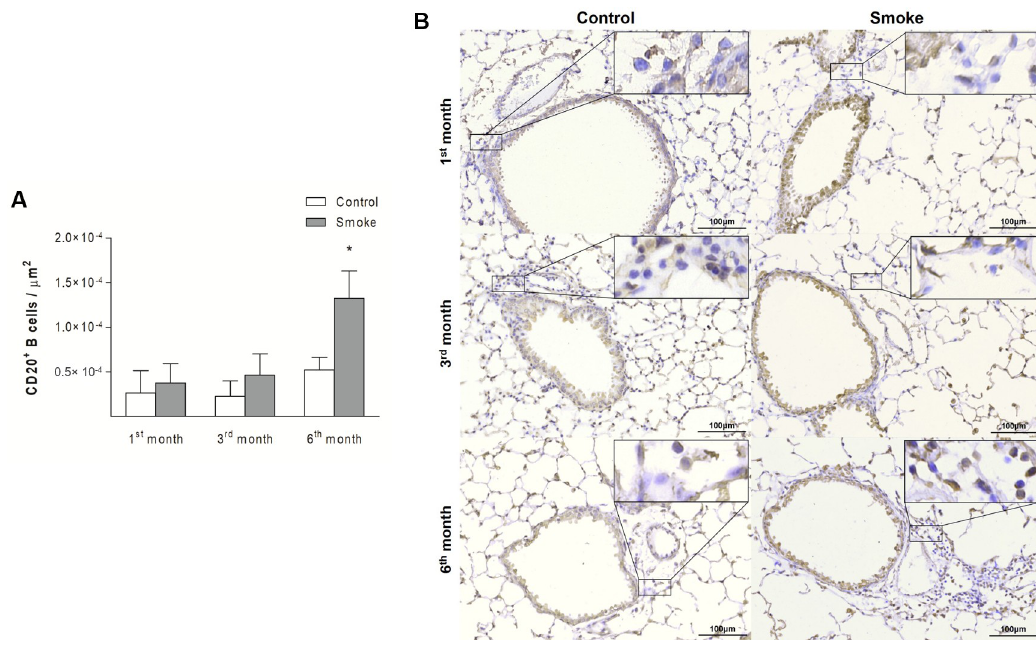
Fig 6. CD20 + B cells in peribronchovascular areas. The numbers of CD20 + B cells in peribronchovascular areas obtained for the Control groups after 1 (n = 9), 3 (n = 6), and 6 (n = 6) months and the Smoke groups after 1 (n = 9), 3 (n = 7), and 6 (n = 8) months are presented as the means ± SDs. (A) Significant difference was found after 6 ( � P = 0.0007, Mann-Whitney test) months. (B) Representative photomicrographs of CD20 + B cells in peribronchovascular areas are shown at 200 × magnification, and images at 1000 × magnification are shown in each insert.